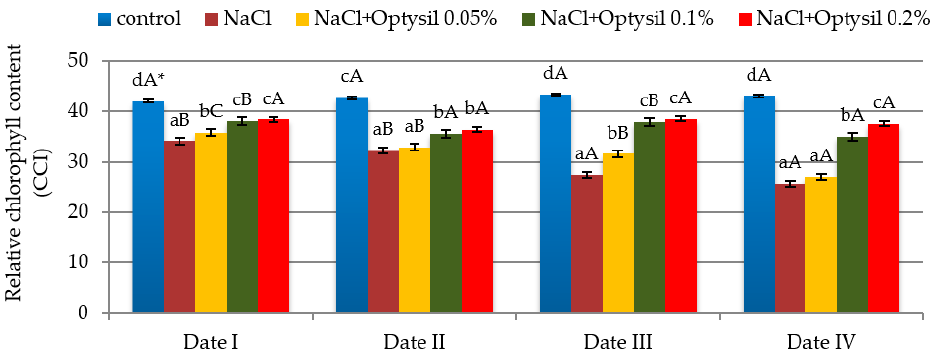
Figure 2. The effect of factors of experiment and measurement date on the chlorophyll content in the oat leaves (CCI); (Date I and Date II, 2 and 7 days after first Si application; Date III and Date IV, 2 and 7 days after second Si application); statistical data are expressed as mean ± SD values. * Capital letters show significant differences between the means in the measurement dates, and lowercase letters show significant differences between the means at next measurement dates ( p = 0.05).